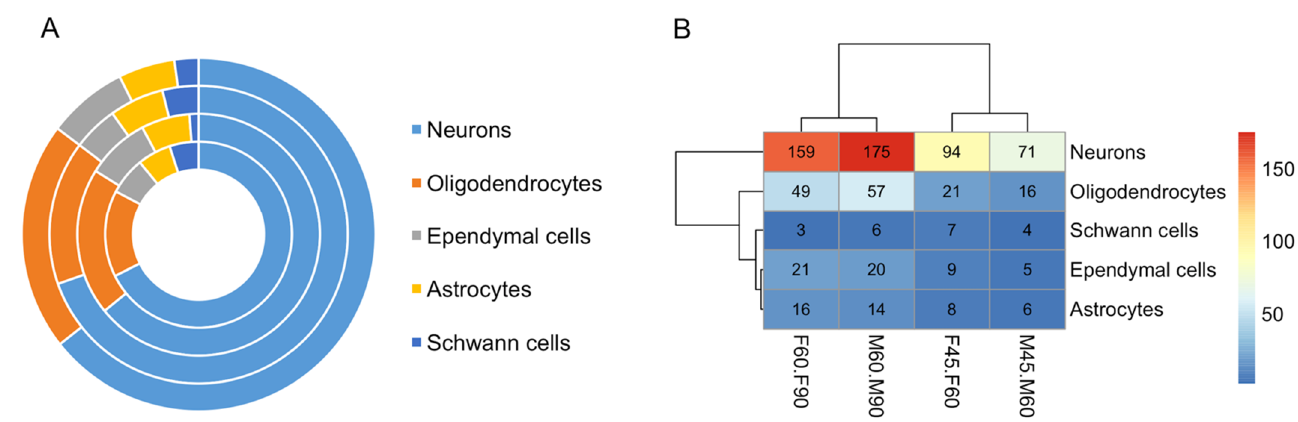
Figure 4. ( A ) Donut plot showing proportion of marker genes representing different brain cells (color coded). The four circles in this donut plot represent the samples in which the marker genes were significantly differentially expressed. From the center to outward direction, these circles represent DE genes between brain samples of F45 vs. F60, F60 vs. F90, M45 vs. M60, and M60 vs. M90, respectively. F and M represent female and male respectively whereas the numbers represent GDs. ( B ) Heatmap showing the number marker genes associated with different cell types of the brain (shown in rows) and GDs during which those genes are significantly differentially expressed in the male and female fetal brain (shown in columns). The cluster patterns of rows and columns are shown along with color scale (in the right). The scale represents the number of DE marker genes of brain cells.